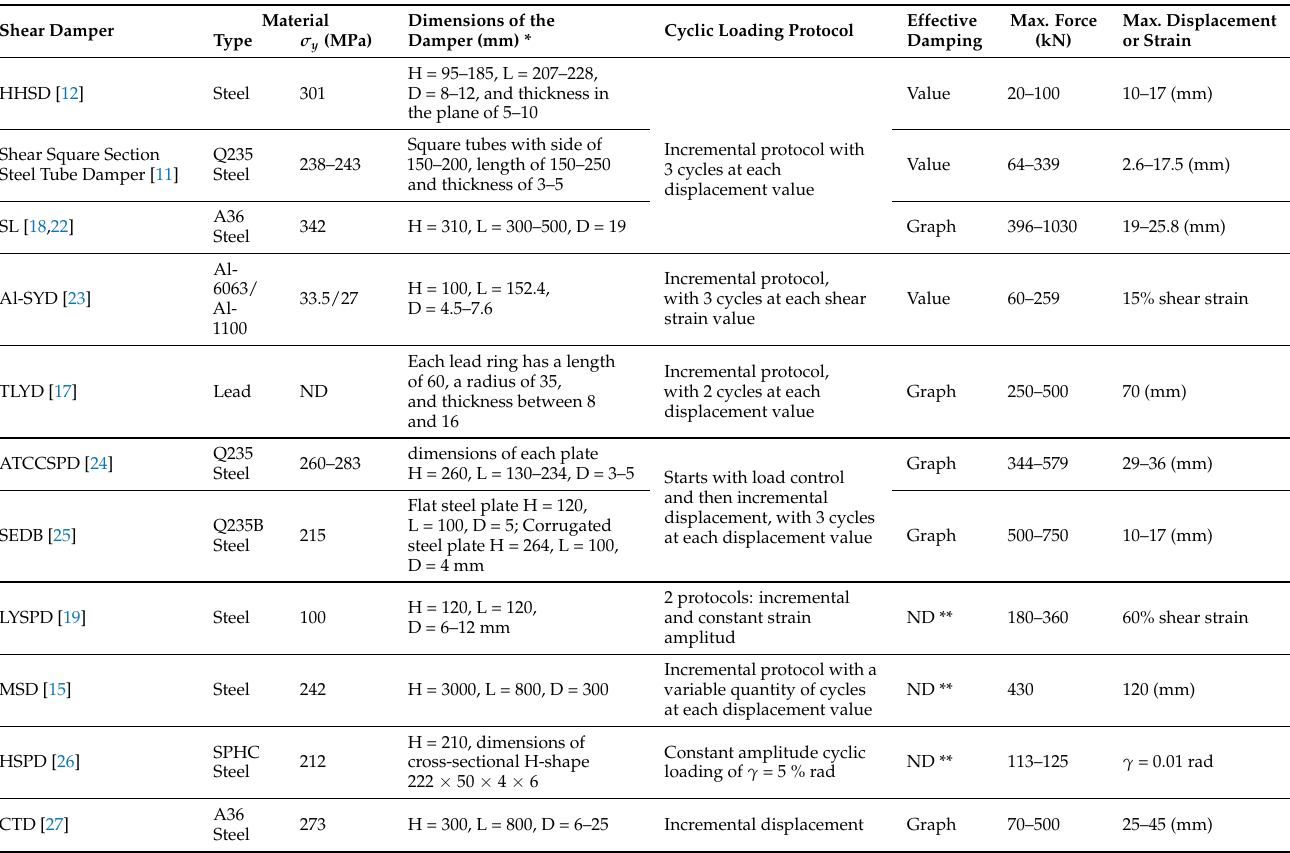
Table 1. Comparison between investigations of shear